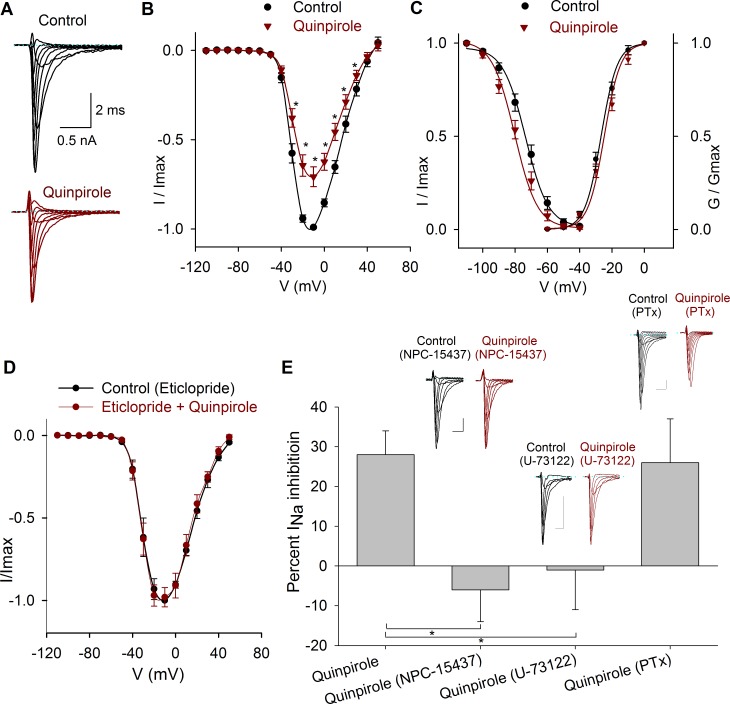
Effects of quinpirole on the INa.A) Typical recordings of the INa under control conditions and after 1 μM quinpirole perfusion. B) Current- voltage relationship of the INa in control conditions and after 1 μM quinpirole. The maximum inhibition was 28 ± 6% at −10 mV. C) Conductance activation and steady state inactivation curves of the INa in control conditions and after 1 μM quinpirole perfusion. Quinpirole caused a 5 mV hyperpolarizing shift in the V½ of the inactivation curve. D) Current-voltage relationship of the INa in control condition (with 1 μM eticlopride) and after coapplication of 1 μM quinpirole. E) Bar graph of the percent inhibition of the INa by quinpirole in control, with NPC-15437 in the intracellular solution (P = 0.004) and when the cells were preincubated with U-73122 (P = 0.02) or PTx (P = 0.82). Insets above bars show typical recordings of the INa in control and after drug application. Calibration bars 0.5 nA, 1 ms for all recordings.